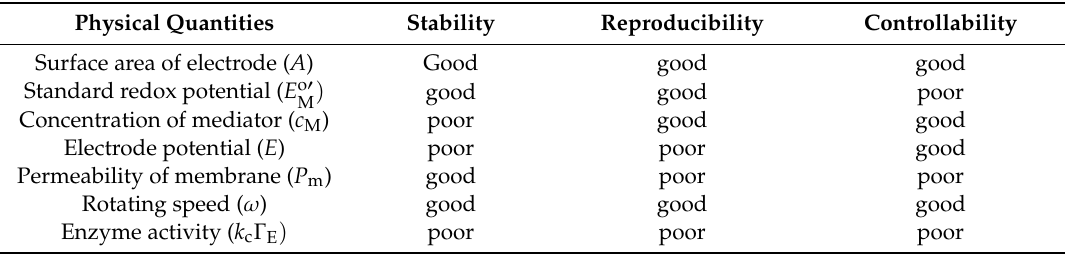
Table 1. Physical quantities a ff ected to the amperometric